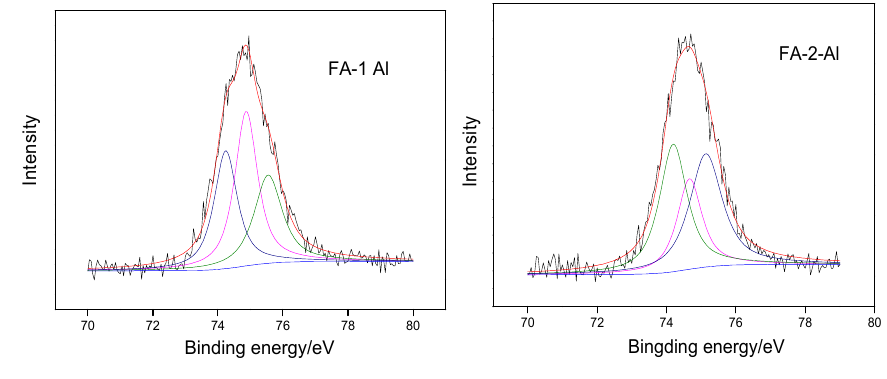
Figure 12. Al 2p XPS spectra for FA-1 and FA-2. Table 7. Fitting results of the Al 2p XPS spectra.